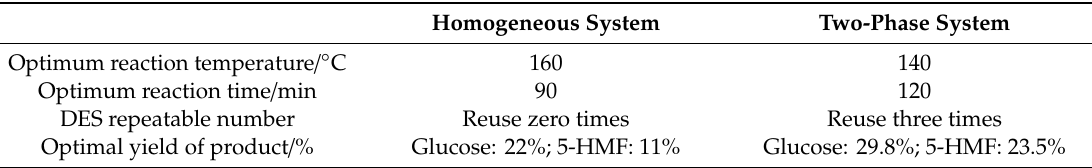
Table 2. Comparisons between one-phase and biphase systems.